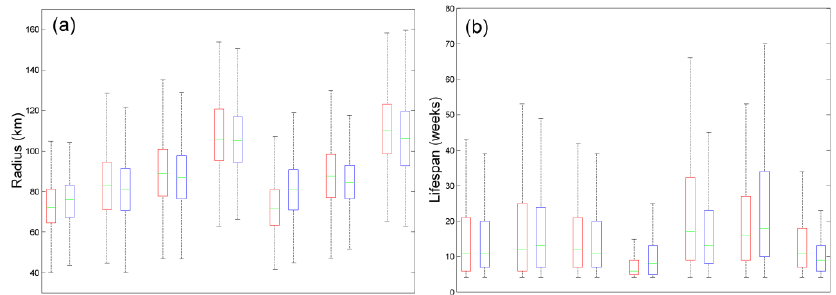
Figure 6. Boxplot of eddy kinematic characteristics in the active regions in Figure 5. The green line is the median value and the box represents the interquartile range. The whiskers are lines extending from each end of the box to show the extent of the rest of the data. The whiskers’ length is 1.5 times that of the interquartile range. If all data lie within the area of 1.5 times the interquartile range, the whiskers end with the minimum or maximum of the data. ( a ) Radius; ( b ) Lifespan; ( c ) Distance; ( d ) EKE; ( e ) Amplitude; ( f ) Speed. Red and blue represent the anticyclonic and cyclonic eddies,